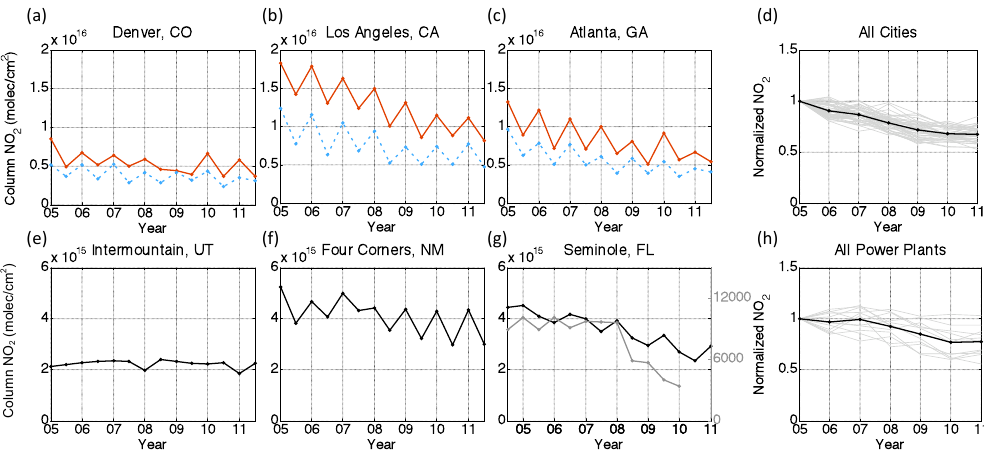
Fig. 2. Time series of average summertime (April–September) and wintertime (October–March) OMI NO 2 column densities for 2005–2011 for three US cities (a–c) and three power plants (e–g) . Average NO 2 column densities in winter are higher than those in summer due to the longer NO x lifetime in winter. For the cities, weekday (red) and weekend (blue) time series are shown, while for power plants the combined weekday and weekend average time series are shown. CEMS power plant emissions (lbs/mmBtu) are shown in gray in (h) . The time series of average summertime columns normalized to 2005 concentrations for each US city and power plant (gray) and the average for all cities and power plants (black) are shown in (d) and (h) ,